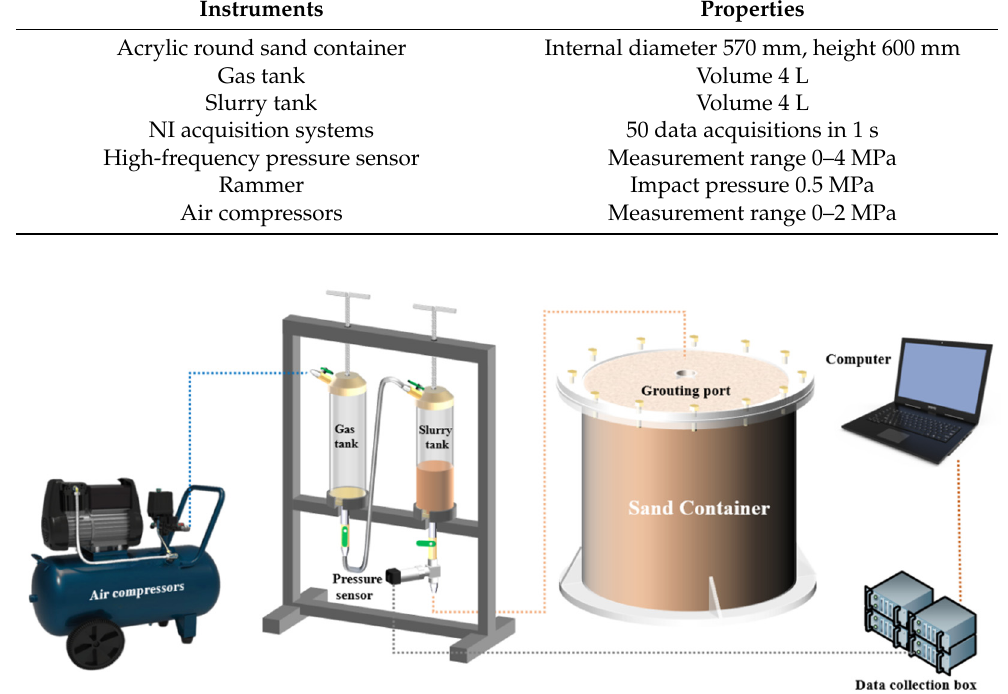
6 of 16 Table 2. Orthogonal test table. Test Number